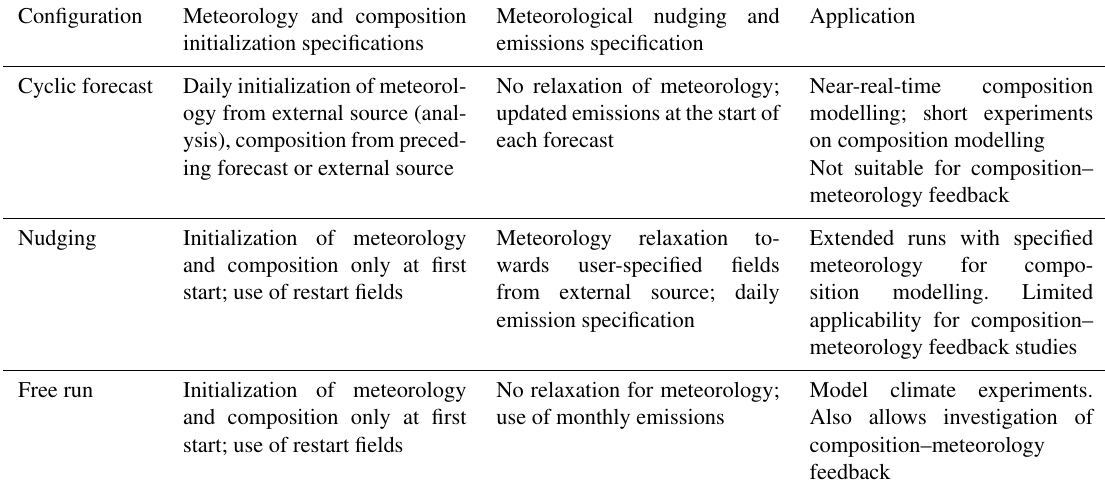
Table 1. Overview of standard configurations to operate OpenIFS/AC experiments.